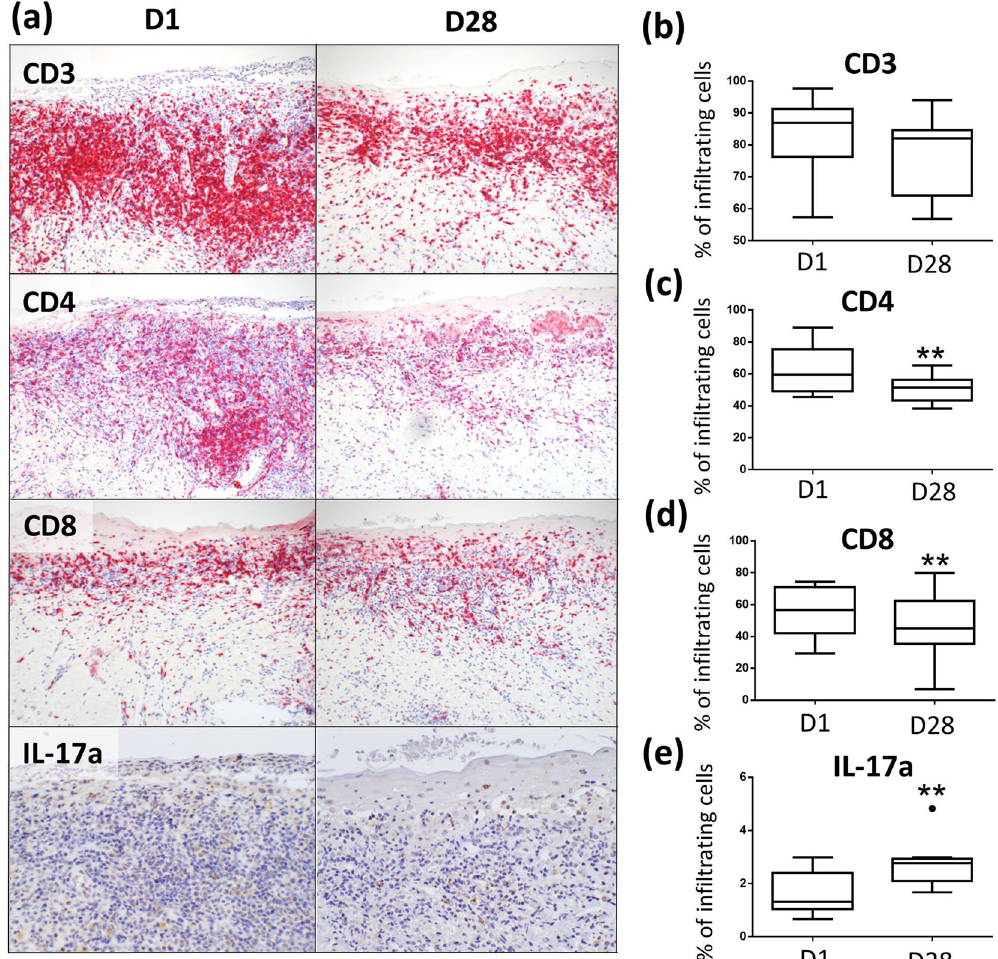
Figure 5. PDT induces local anti-inflammatory effects in OLP. ( a ) Overview of immunohistochemical staining of mucosal tissue sections with a lesional T- cell infiltrate before and after PDT treatment (D1, D28). ( b–d ) Relative number of lesional CD3 + , CD4 + and CD8 + cells are decreased 14 days after PDT treatment. ( e ) Relative number of lesional IL-17 + cells is increased 14 days after PDT treatment. ** p < 0.01. PDT, photodynamic